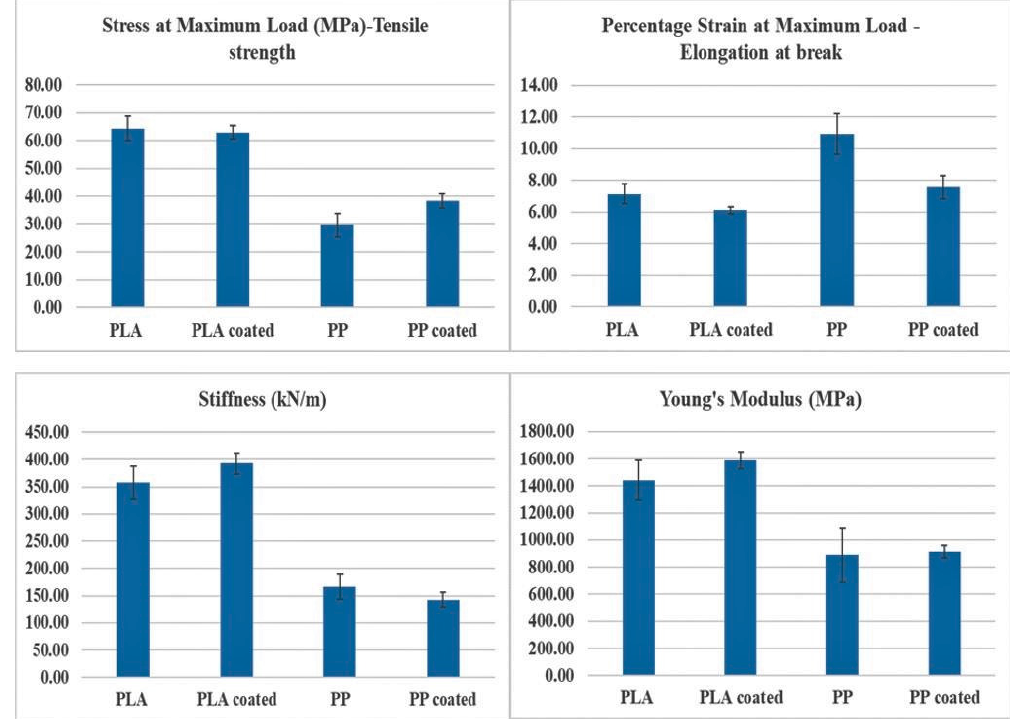
Figure 6. Graphical representation of the mechanical properties of the polymers with and without ZnO coating. There is no significant difference between the coated samples (ZnO@PLA ZnO@PP) and their uncoated counterpart samples.